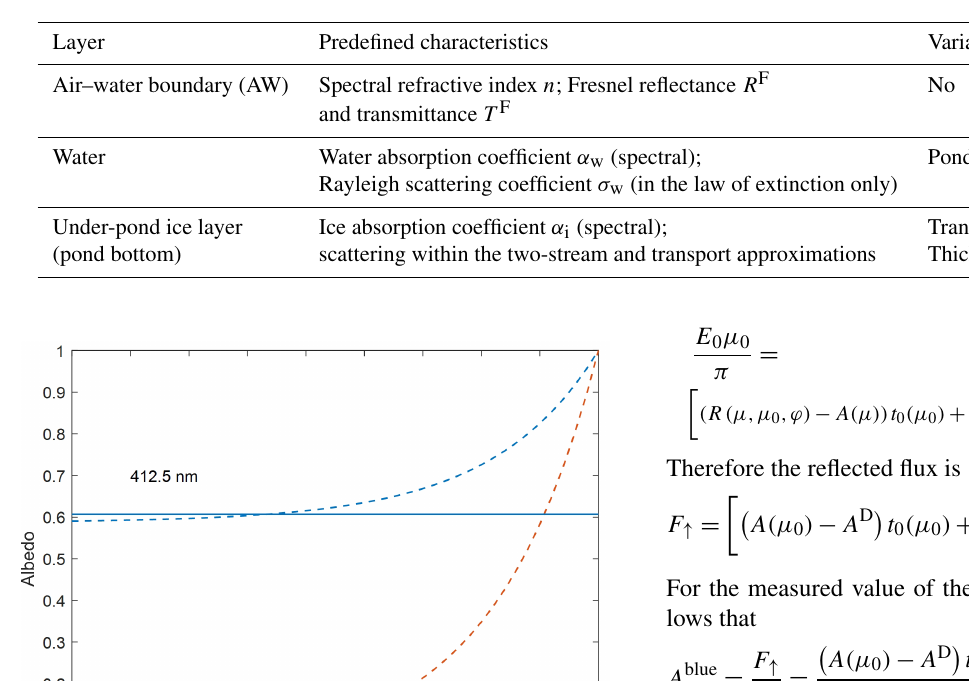
Table 1. Melt pond characteristics.